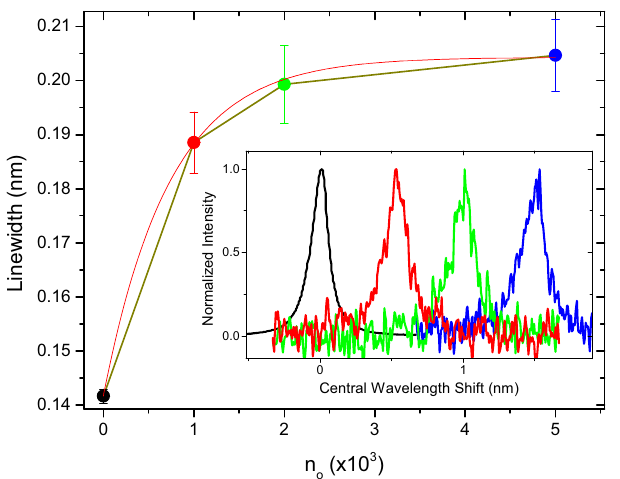
Fig. 8 Free carrier related optical losses. Evolution of the optical linewidth of the fi rst cavity mode with respect to the number of intracavity photons populating the second cavity mode. The red curve is a fi t to the experimental data using Eq. (5). The inset shows the fi rst optical resonance and its spectral shift when the number of intracavity photons is increased. The Lorentzian fi t of those peaks was used to extract the linewidths values of the main panel. The colour code of the curves in the inset is linked to the number of intracavity photons of the points of the main panel. The vertical error bars in the main panel are associated to the quality of the lorenzian fi t of the curves in the inset.